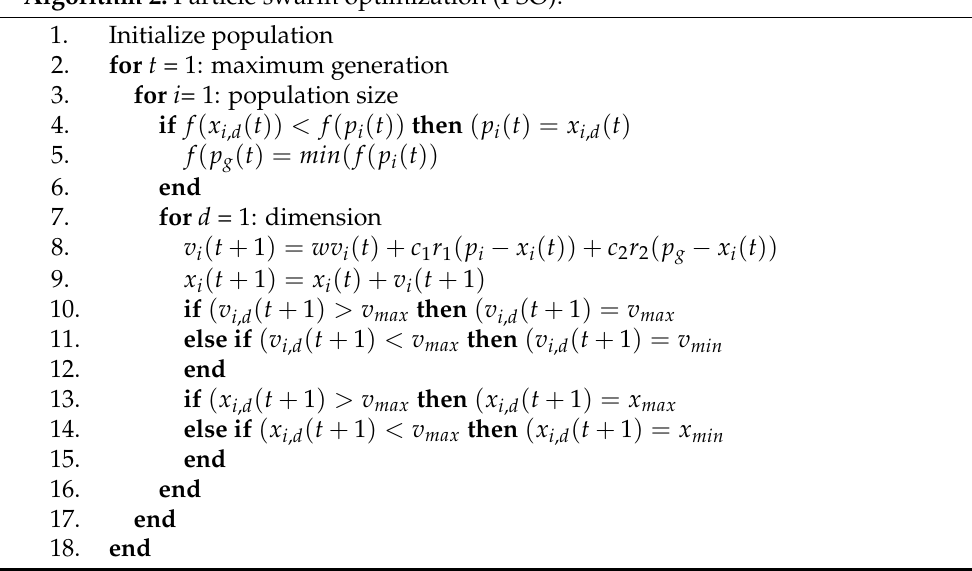
Algorithm 2: Particle swarm optimization (PSO).